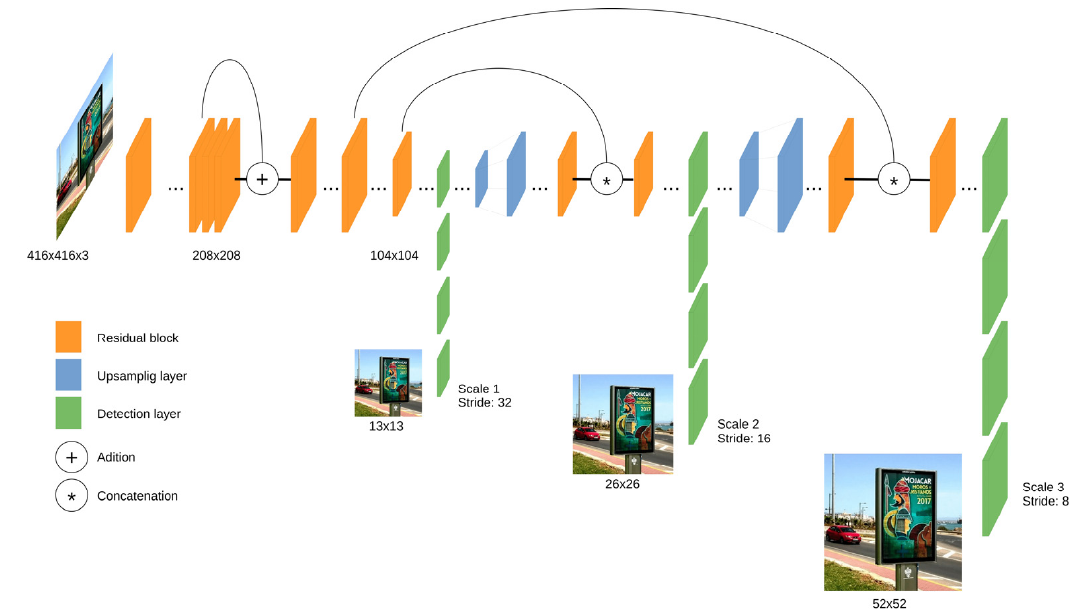
Figure 3. Simplified layer architecture of You Only Look Once (YOLO)v3 network.